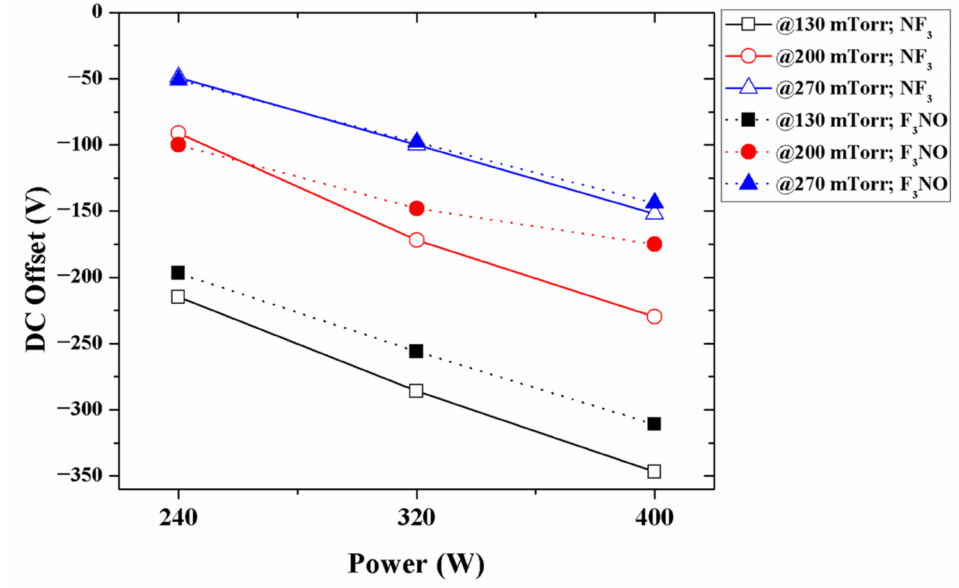
Figure 2. DC offset of the RF electrode during plasma discharge at a total flow rate of 120